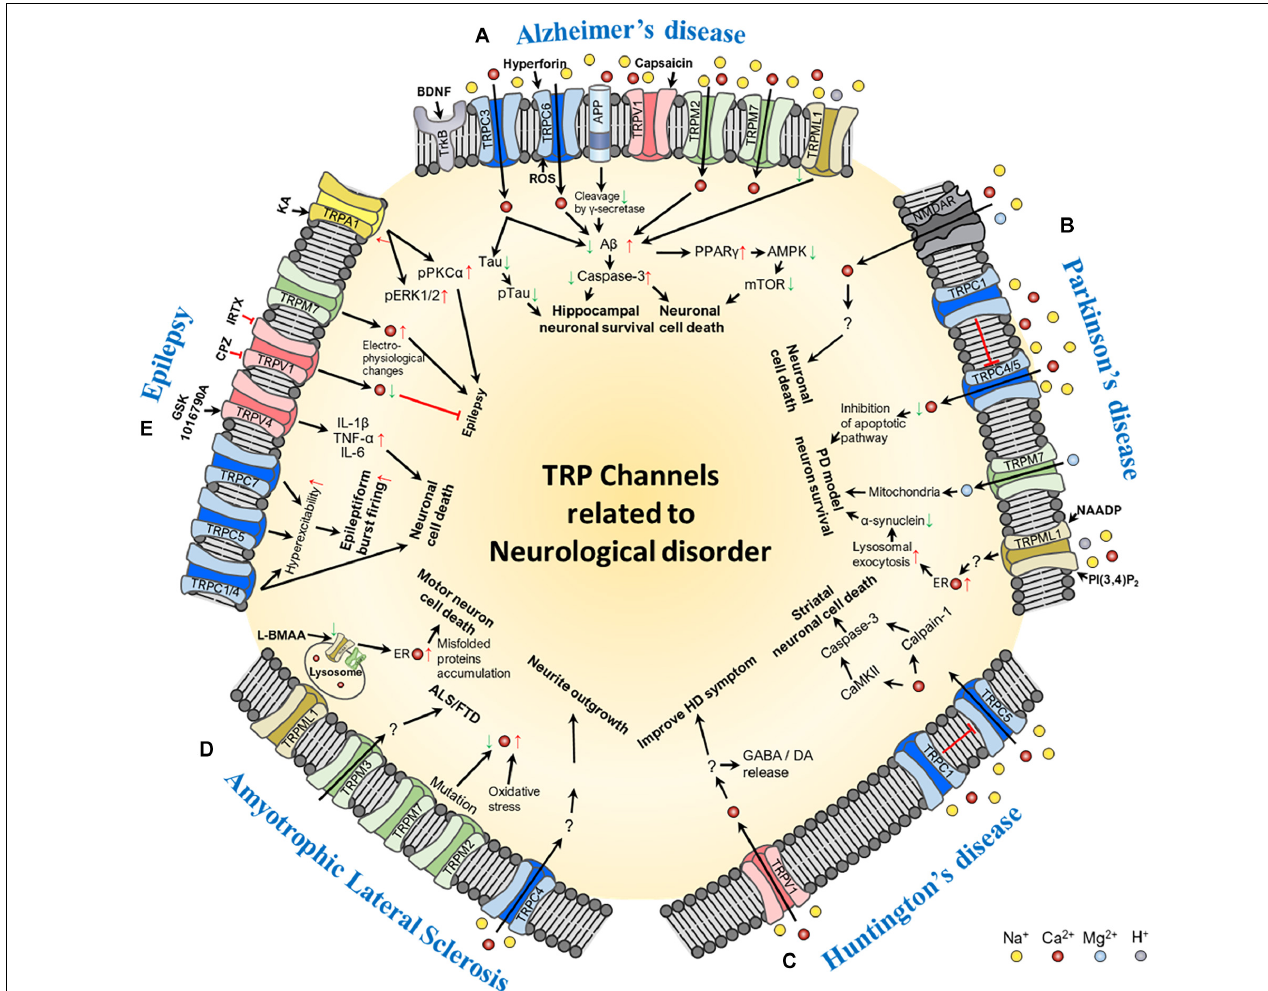
FIGURE 1 | Schematic of the molecular mechanism of TRP channel-mediated pathogenesis of neurological disorders: (A) Alzheimer’s disease, (B) Parkinson’s disease, (C) Huntington’s disease, (D) Amyotrophic lateral sclerosis, and (E) epilepsy. In the figure, red arrows represent increase or up-regulation; green arrows, decrease or down-regulation; red thick bar, inhibition of the signaling pathway; and black arrows, activation of the signaling pathway. Ion channels involved in each of the neurological disorders and their transporting ions, channel agonists, and antagonists are also shown in the figure. Abbreviations : BDNF, brain-derived neurotrophic factor; ROS, reactive oxygen species; A β , beta-amyloid; PPAR, peroxisome proliferator-activated receptor gamma; AMPK, 5 (cid:48) adenosine monophosphate-activated protein kinase; mTOR, mechanistic target of rapamycin; NMDAR, N-methyl-D-aspartate receptor; NAADP, Nicotinic acid adenine dinucleotide phosphate; PI(3,4)P 2 , phosphatidylinositol (3,4)-bisphosphate; PD, Parkinson’s disease; ER, endoplasmic reticulum; GABA, gamma-aminobutyric acid; DA, dopamine; ALS/FTD, amyotrophic lateral sclerosis patients with frontotemporal dementia; L-BMAA, L-beta-methylamino-L-alanine; IL, interleukin; TNF- α , tumor necrosis factor alpha; CPZ, capsazepine; IRTX, 5 (cid:48) -Iodoresiniferatoxin; KA, kainic acid; pPKC α , phospho-protein kinase C alpha; pERK1/2, phospho-extracellular signal-regulated kinase